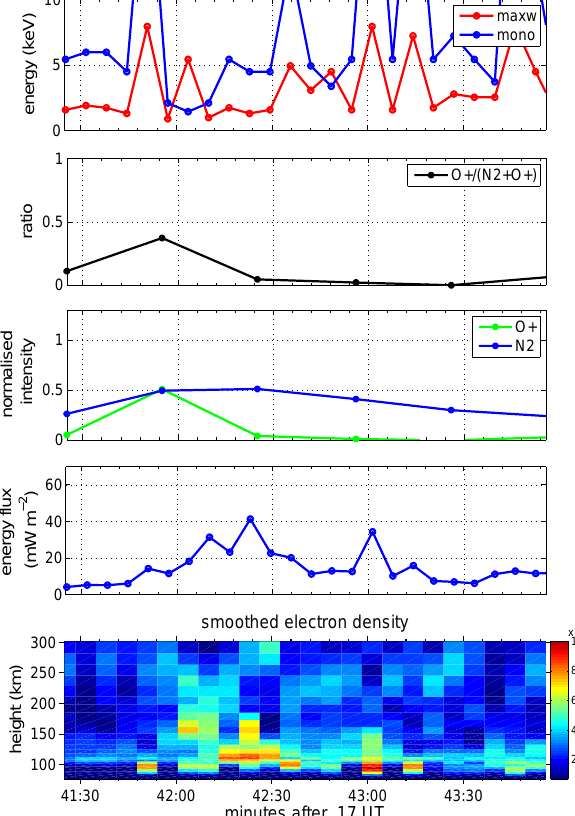
Fig. 7. Electron transport model results compared with optical re- sults: Panel 1: peak electron energy for event 2, when assuming the input electron spectrum at the top of the ionosphere to be monoen- ergetic, Panel 2: O + /(O + + N 2 ) ratio, Panel 3: O + intensity (green) and N 2 intensity (blue), Panel 4: fitted energy flux below 150km, Panel 5: Smoothed electron density height